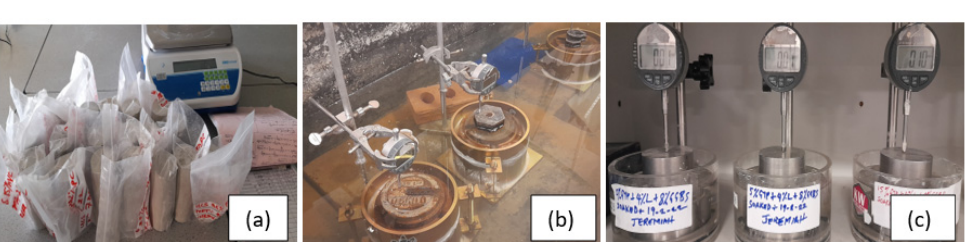
Figure 3. Treated gypseous soil specimens. ( a ) UCS samples. ( b ) Soaking of CBR samples. ( c ) Swell testing.